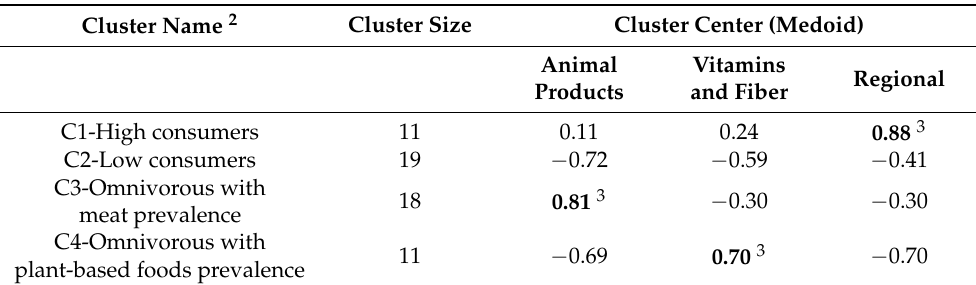
Table 4. Description of the dietary patterns identified at baseline from cluster analysis 1 : cluster size (i.e., number of subjects included in each cluster) and cluster centers. Italy,